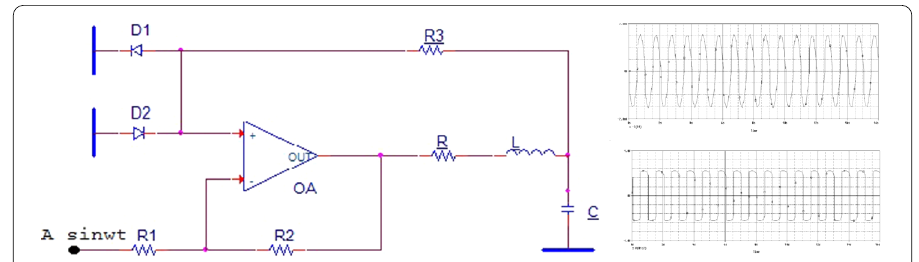
Figure 1 Duffing oscillator